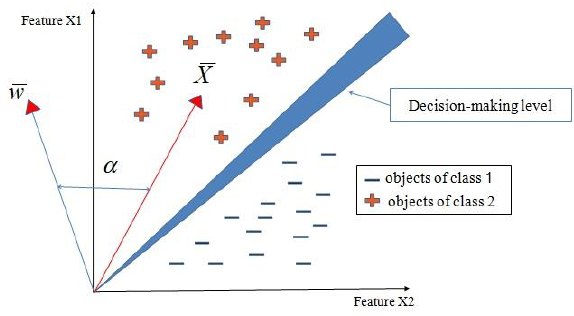
Figure 14. Example of classification for sample features.